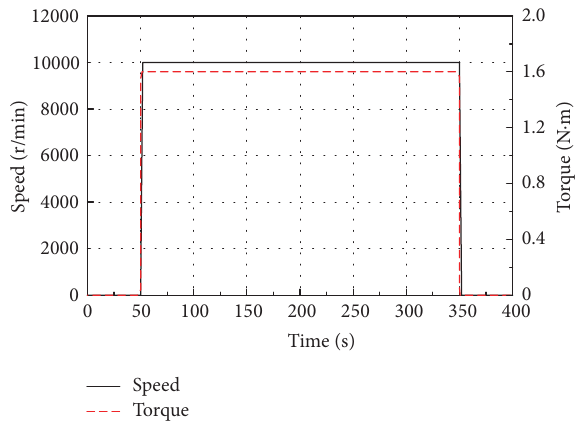
Figure 1: Load profile of the